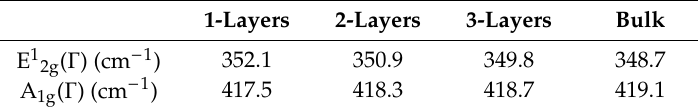
Figure 9. ( a ) Raman spectrum of WS 2 at four di ff erent test points; ( b ) PL spectrum of WS 2 at four di ff erent test points; ( c ) Power Raman spectrum of WS 2 ; ( d ) Power PL spectrum of WS 2. Table 1. A 1g peak and E 1 2g peak positions of di ff erent WS 2